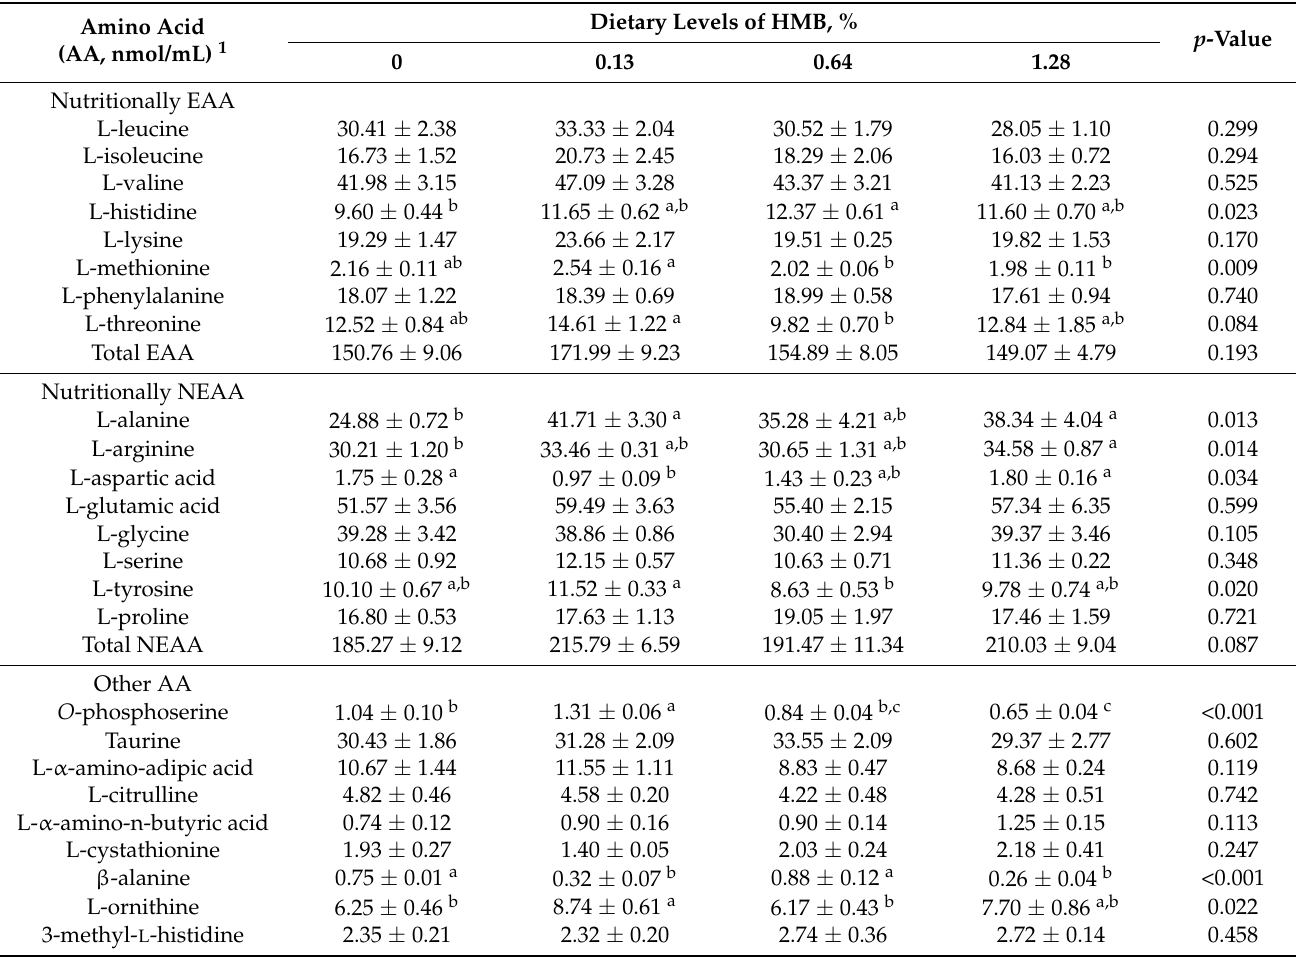
Table 2. Amino acid concentrations in the serum of Bama Xiang mini-pigs fed diets with different levels of beta-hydroxy beta-methyl butyrate (HMB) ( n = 8).